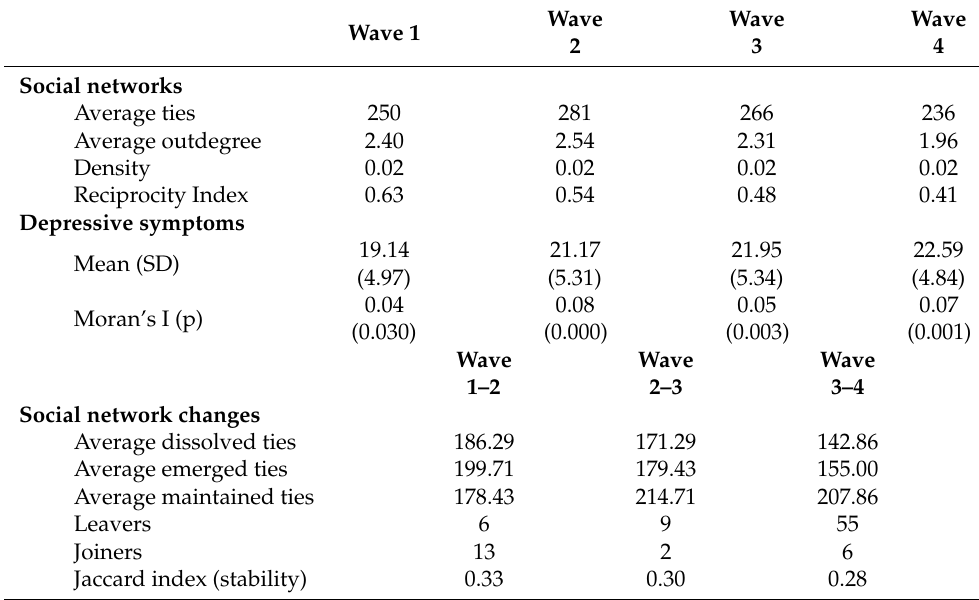
Table 3. Descriptive results for depressive symptoms and peer network changes.